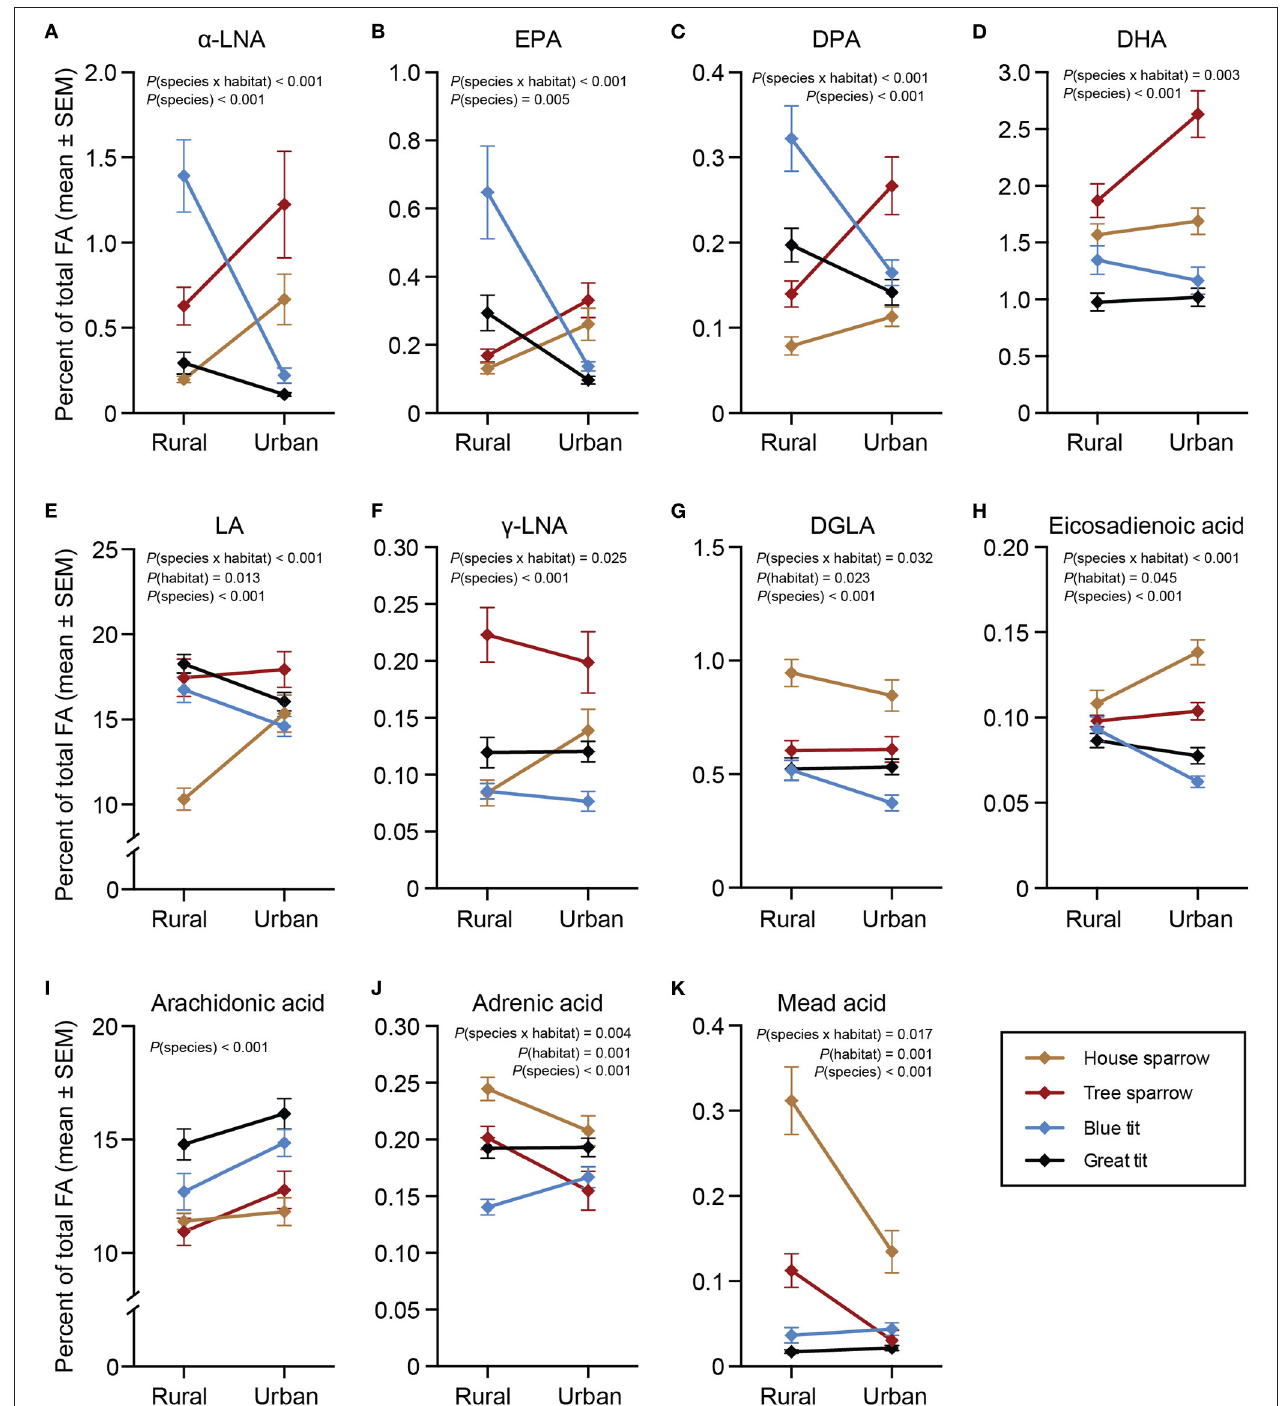
FIGURE 2 | Plasma polyunsaturated fatty acids (%) in four species of passerines from urban and rural environments. (A–D) ω -3 polyunsaturated fatty acids (PUFAs), (E–J) ω -6 PUFAs, and (K) ω -9 PUFA. Data are plotted as means ± standard error of the means (SEM). Note the different scales on the y -axes. Significant effects of species, habitat and/or the habitat × species interaction are indicated by the P- values. For n -values see Table 1 . One urban blue tit did not have detectable levels of DGLA, thus the sample size was reduced from 29 to 28. α -LNA, α -linolenic acid; EPA, eicosapentaenoic acid; DPA, docosapentaenoic acid, DHA, docosahexaenoic acid; LA, linoleic acid; γ -LNA, γ -linolenic acid; DGLA, dihomo- γ - linolenic acid.